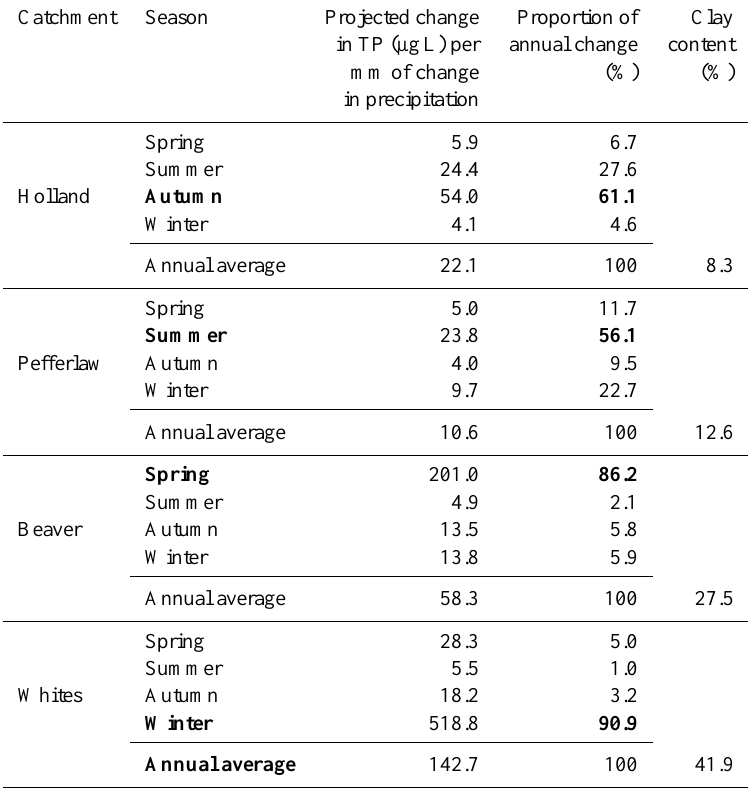
Table 9. Estimation of average catchment sensitivity of water quality to uncertainty in precipitation: projected change in total phosphorus (mgL − 1 ) per mm change in precipitation averaged over 2030’s and 2070’s (1d.p.) highlighting (in bold) the seasons of greatest